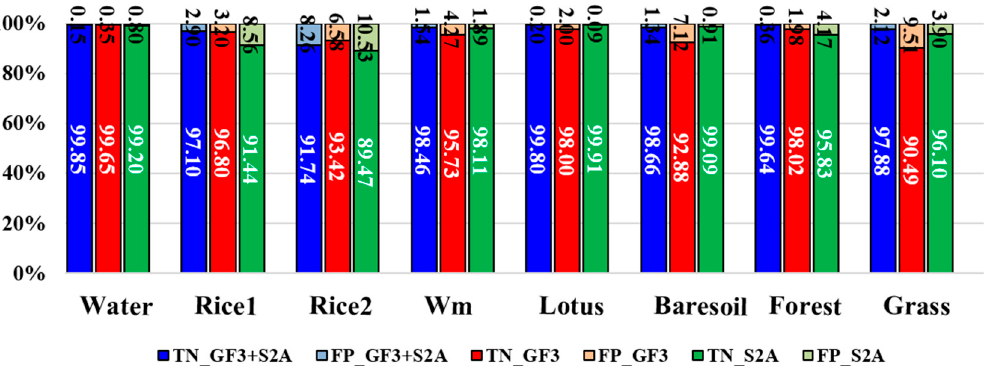
Figure 8. True negative (TN) rates and false positive (FP) rates of different plants from different datasets. Wm means watermelon.